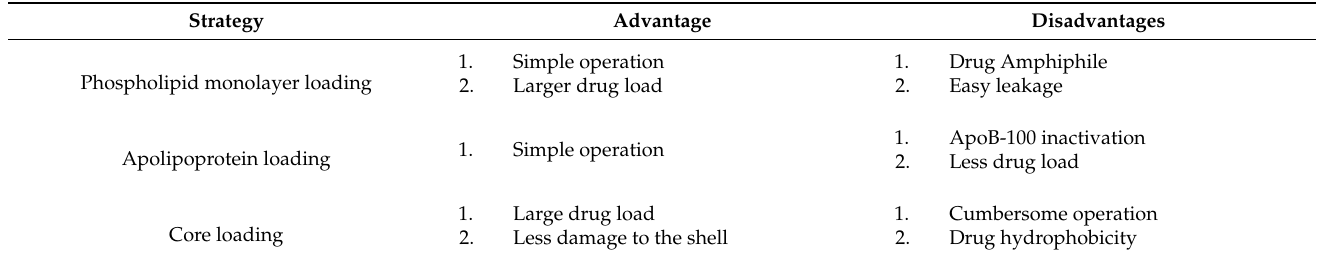
Table 1. Advantages and disadvantages of different modification